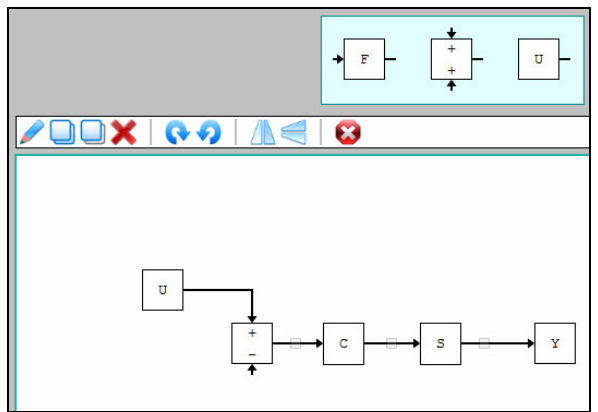
Figure 4. Web application for simplification of block